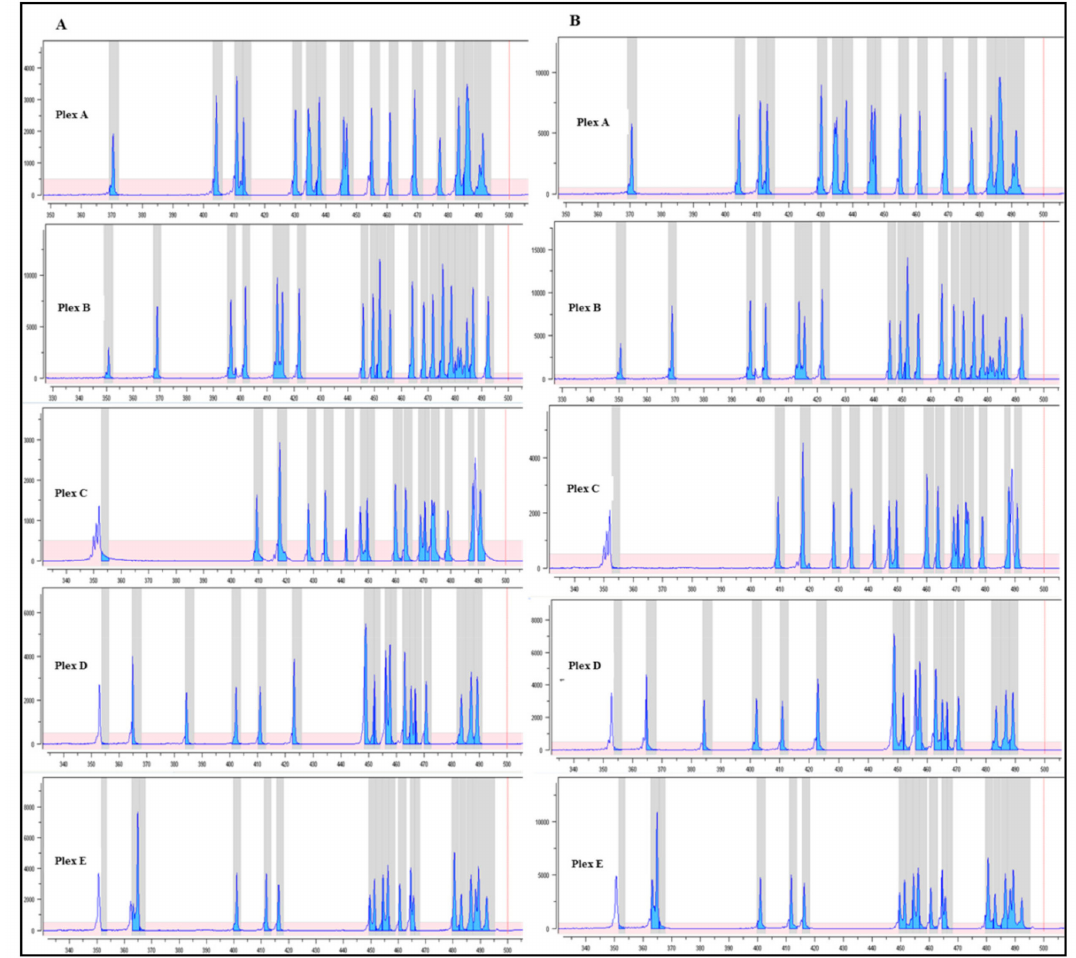
Figure 6. Fragment analysis profile. Quality of the multiplex PCR based on the pattern of amplicons of a five plex relative to the BRCA1 / 2 MASTR Dx assay (Multiplicom). Panel ( A ) shows the profile for